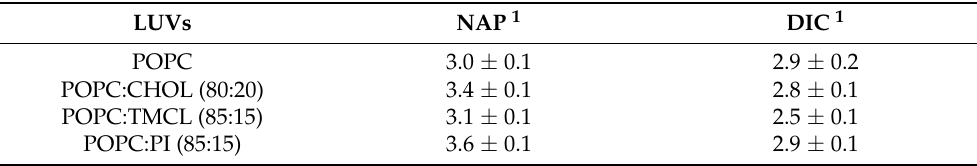
Table 1. Partition coefficient, expressed as log D , of NAP and DIC at 37 °C and pH 7.4 according to the lipid composition of LUVs.